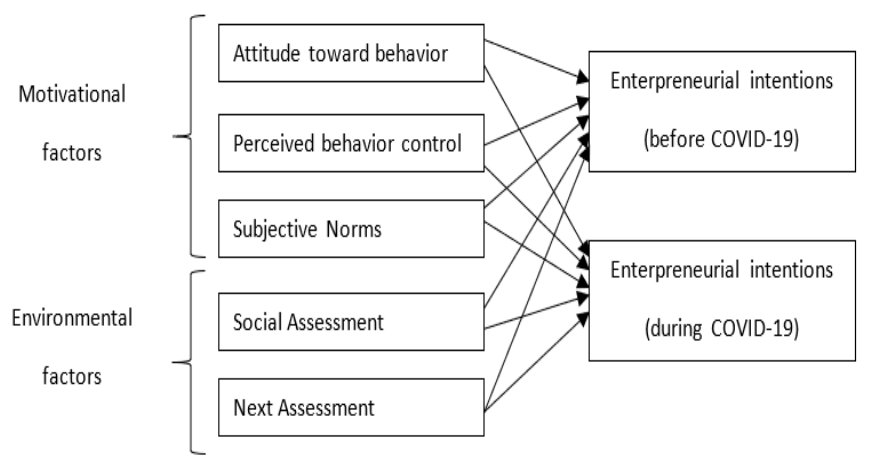
Figure 1. Investigation